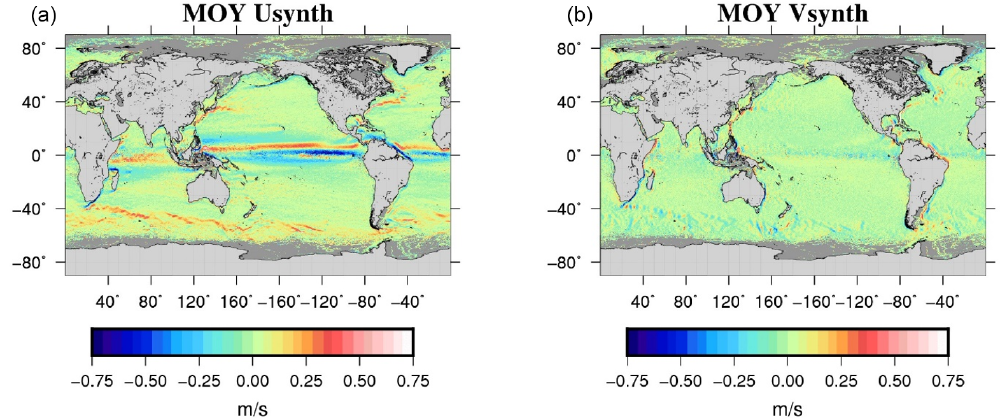
Figure 4. Mean zonal (a) and meridional (b) synthetic